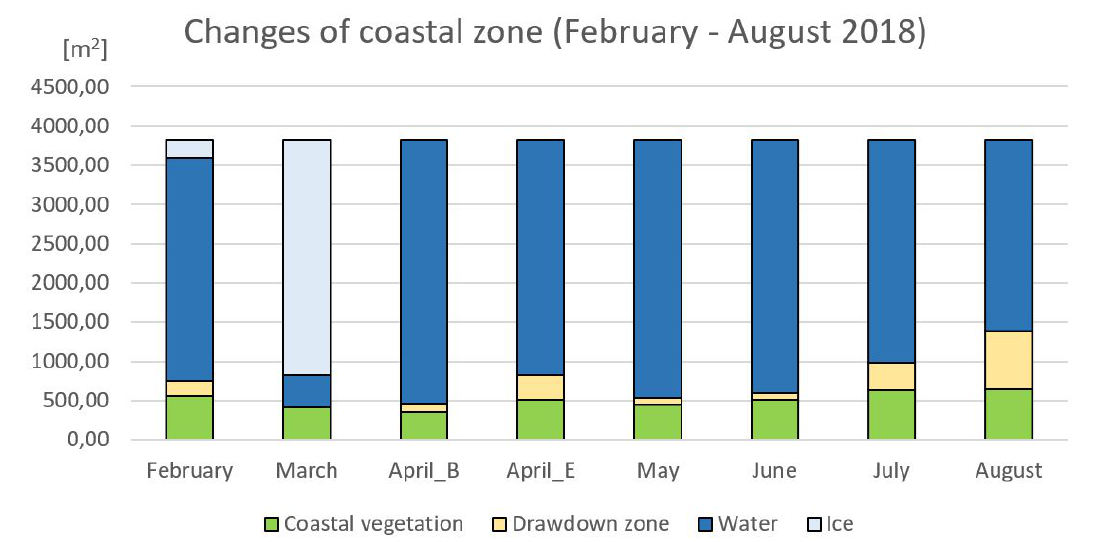
Figure 8. Changes in the monitored categories in individual time